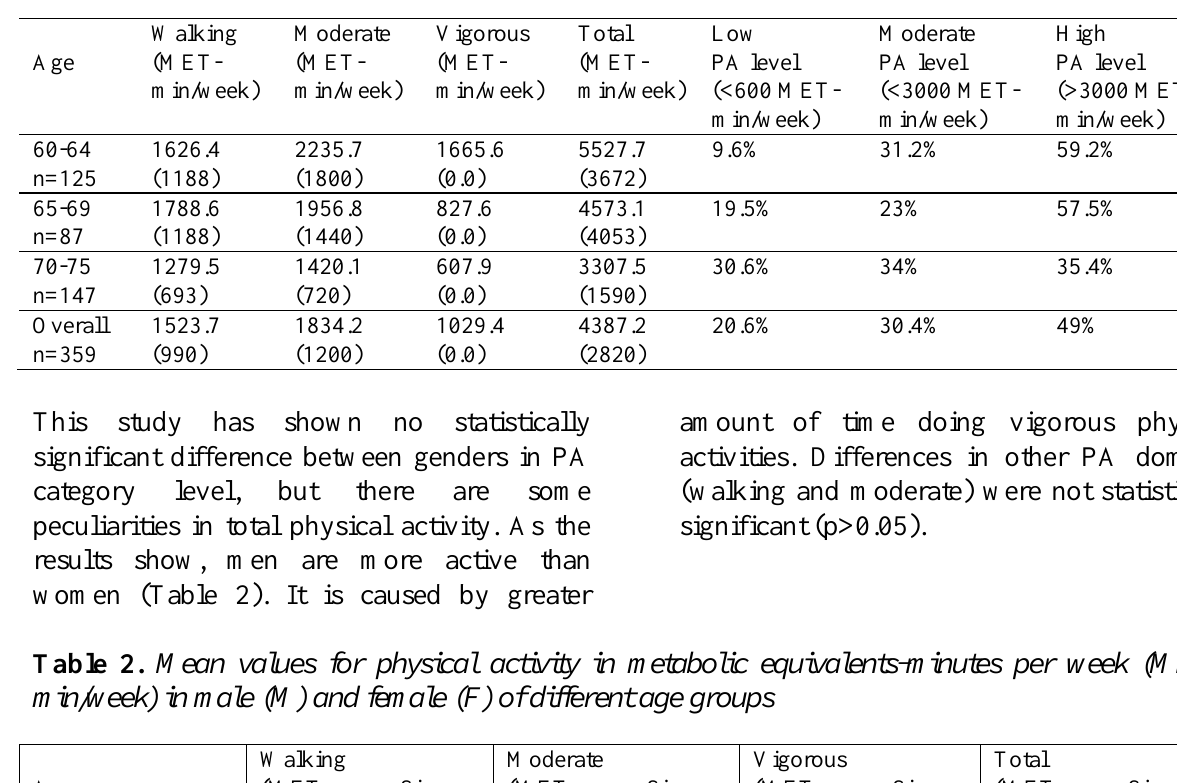
Table 1. Mean (median) values for physical activity in metabolic equivalents-minutes per week (MET-min/week) and physical activity level in different age groups